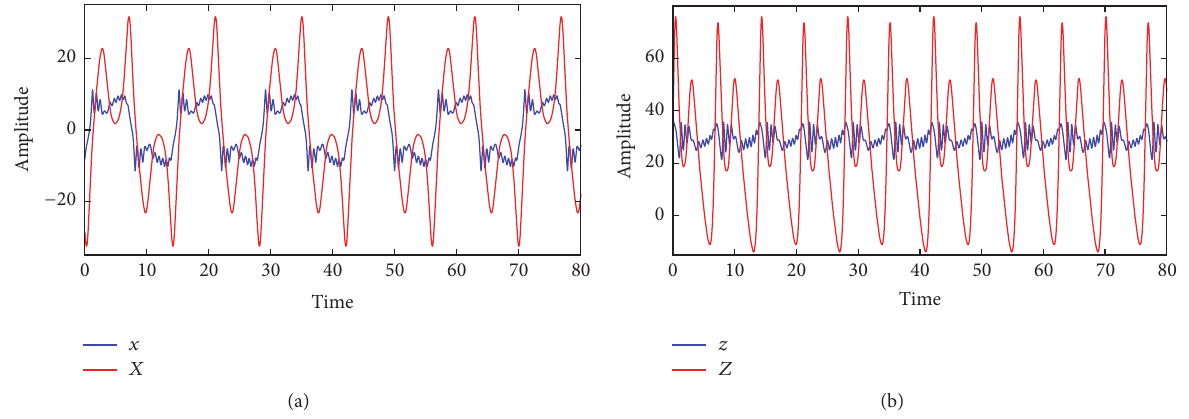
Figure 3: Fast ( 𝑥 and 𝑧 ) and slow ( 𝑋 and 𝑍 ) variables for the case of 𝑐 = 0.8 .